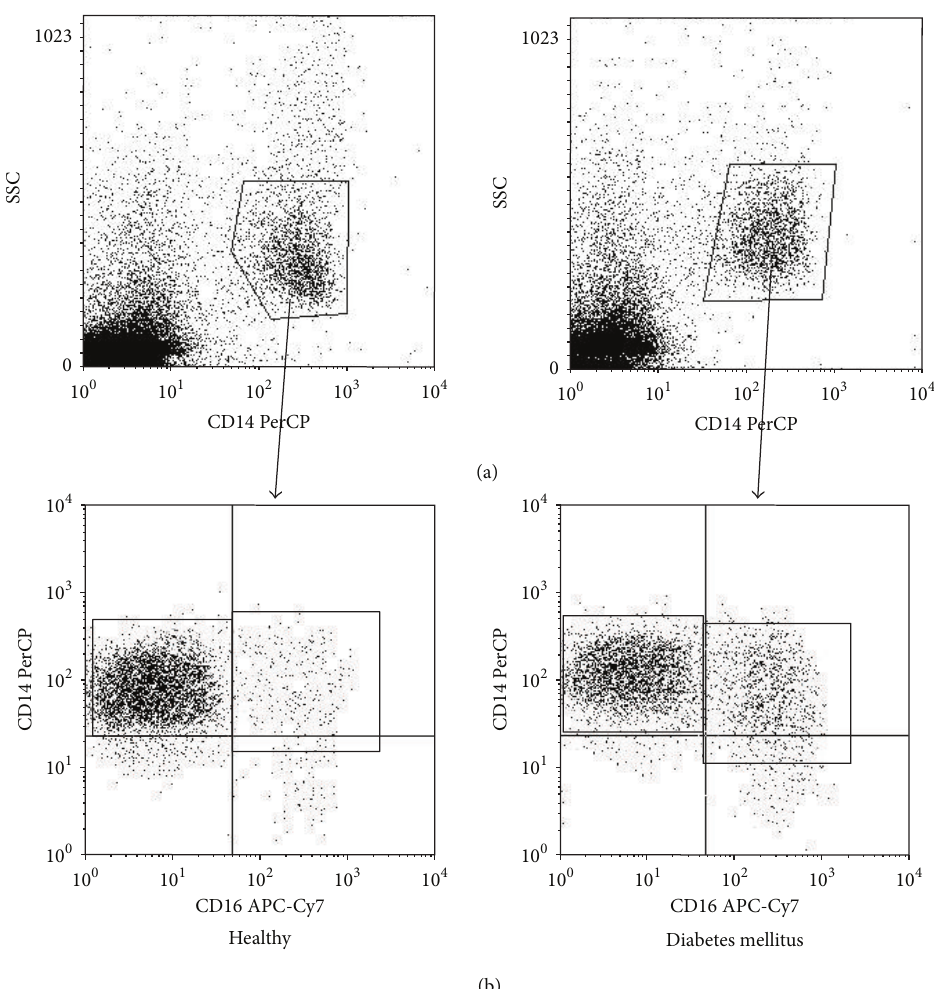
Figure 1: The representative dot plot of monocytes in the healthy and DM1 patients. Monocytes were identified by combination of the SSC parameter and the expression of CD14 molecule (a). Among the CD14 + monocytes two subsets were identified on the basis of CD16 receptor expression, the CD14 ++ CD16 − and CD14 + CD16 +